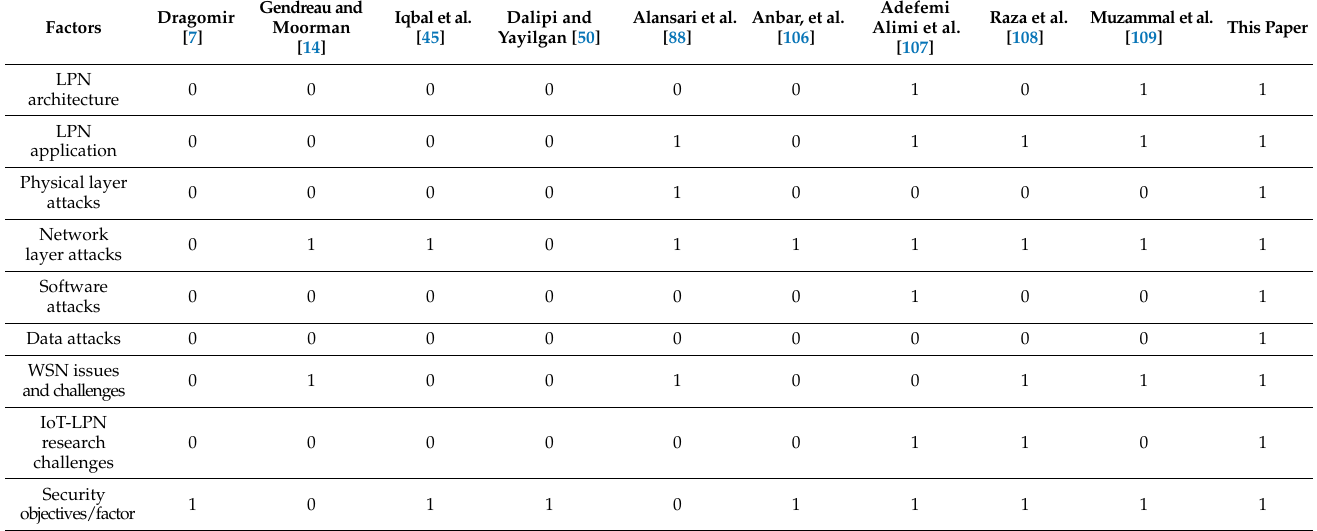
Table 6. Comparative analysis with existing